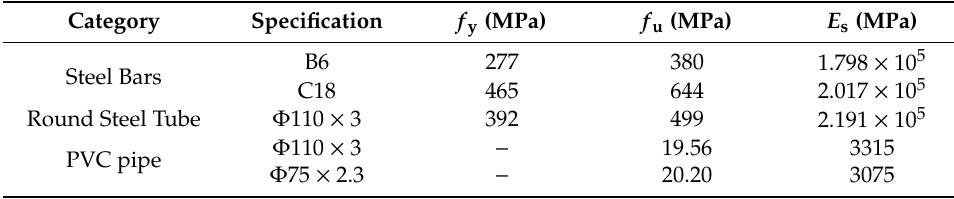
Table 3. Physical properties of steel bars and tubes.